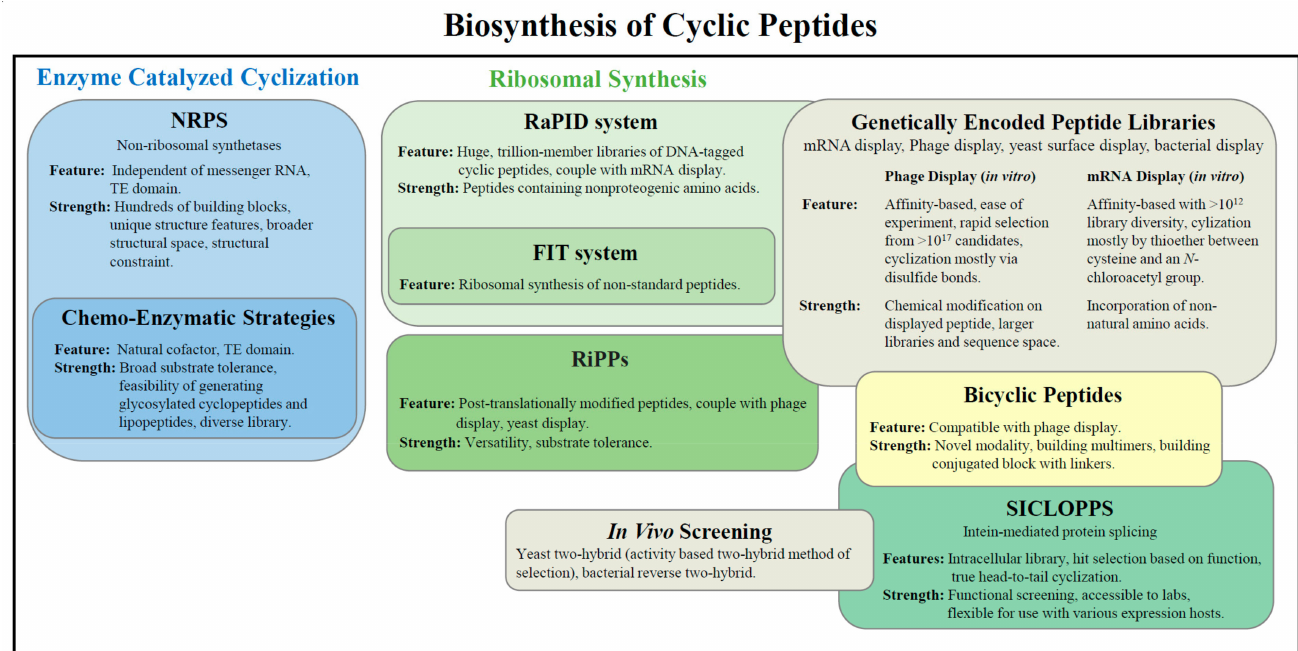
Figure 1. An overview of the platforms discussed in this review. The biosynthesis of bicyclic peptides is highlighted in yellow (FIT: flexible in vitro translation; RaPID: random nonstandard peptides integrated discovery; RiPPs: ribosomally synthesized and post-translationally modified peptides; SICLOPPS: split-intein circular ligation of peptides and proteins; NRPS: non-ribosomal synthetase; TE domain: thioesterase